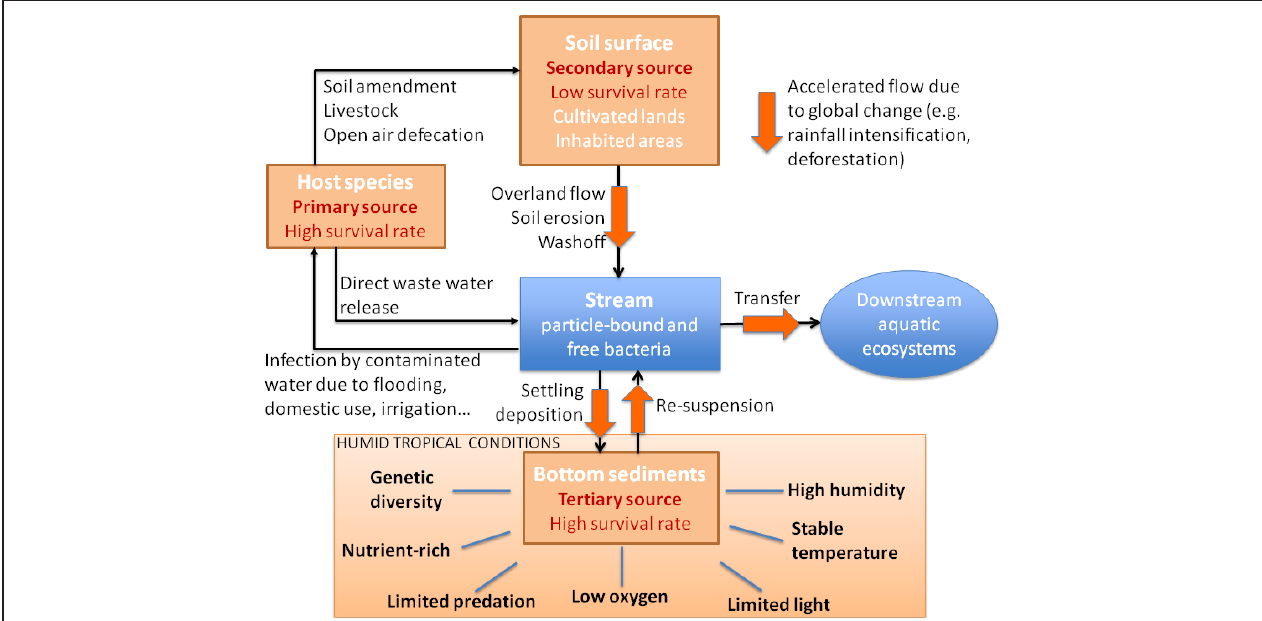
FIGURE 2 | Conceptual diagram of the primary, secondary, and tertiary sources of FIB in humid tropical environments. Humans and livestock are the primary sources of FIB and are responsible for the direct contamination of soils and water. The secondary reservoir is comprised of cultivated land and inhabited rural areas that have been contaminated by the